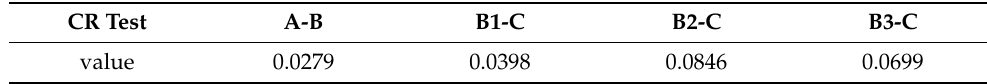
Table 4. The CR test of judgment matrix (source: author).